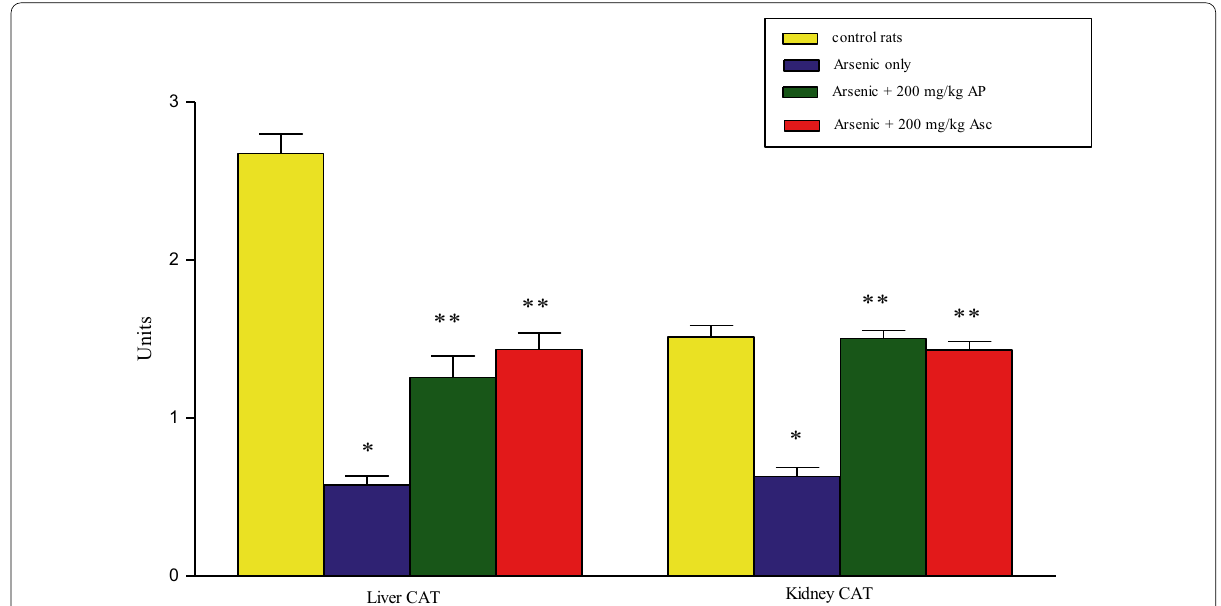
Fig. 5 Effect of methanolic extract of A. paniculata on hepatic and renal CAT activities in arsenic-induced rats. Values are mean *( p < 0.05) Group 2: (arsenic group rats) compared with group 1: (control rats). **( p < 0.05) Groups 3 and 4: ( A. paniculata or ascorbic acid administered rats, respectively) compared with group 2: (arsenic group rats)